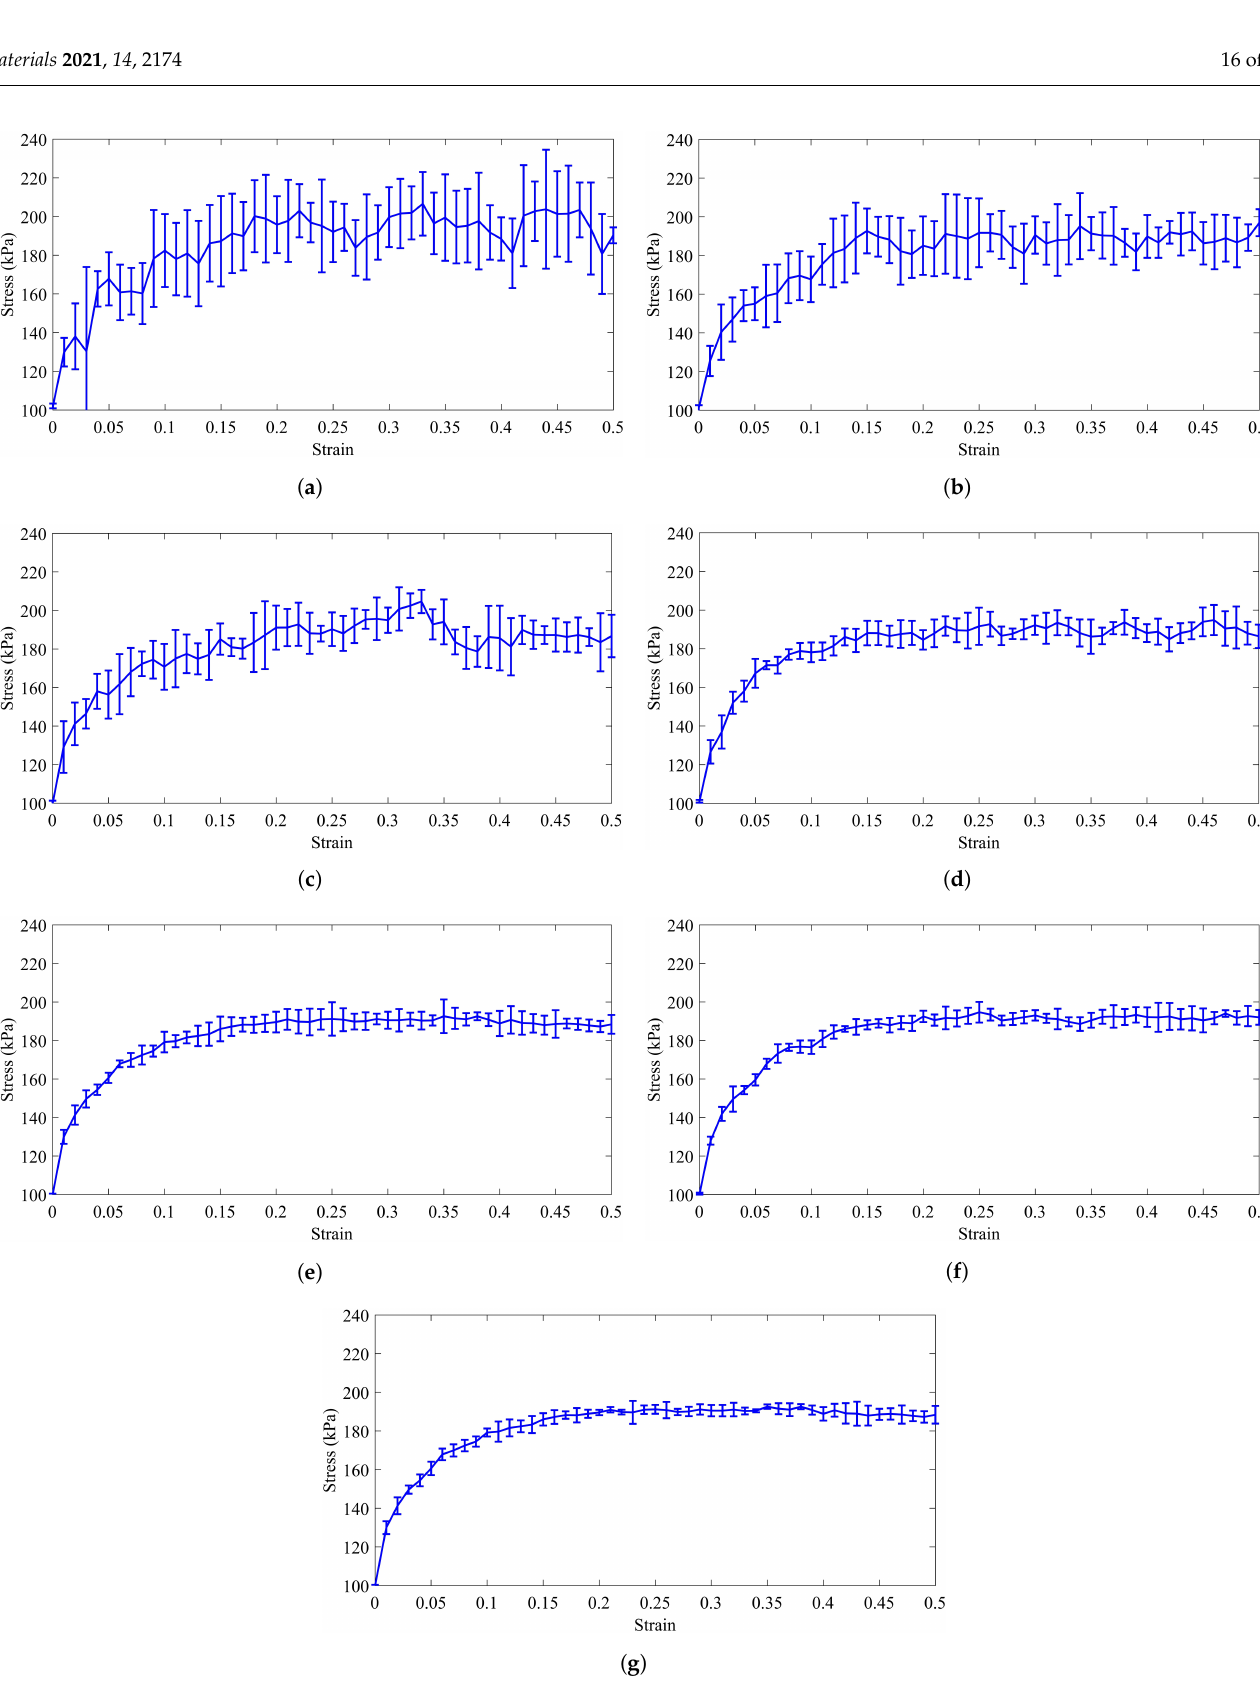
Figure 8. The average of shear behavior of the RVEs with ( a ) 150, ( b ) 300, ( c ) 500, ( d ) 1000, ( e ) 2000, ( f ) 3000, and ( g ) 4000 particles and periodic boundary conditions. The error bars indicate the standard deviation for five times of simulation for each